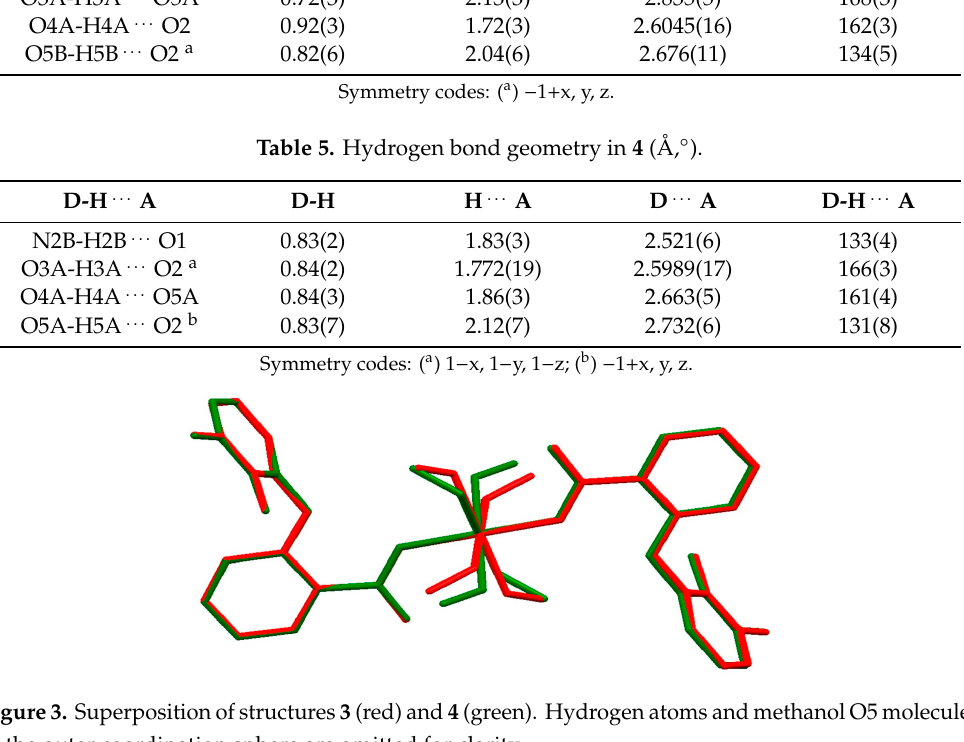
Table 4. Hydrogen bond geometry in 3 (Å, ◦ ). Figure 3. Superposition of structures 3 (red) and 4 (green). Hydrogen atoms and methanol O5 molecules in the outer coordination sphere are omitted for clarity. Table 4 . Hydrogen bond geometry in 3 (Å,°).